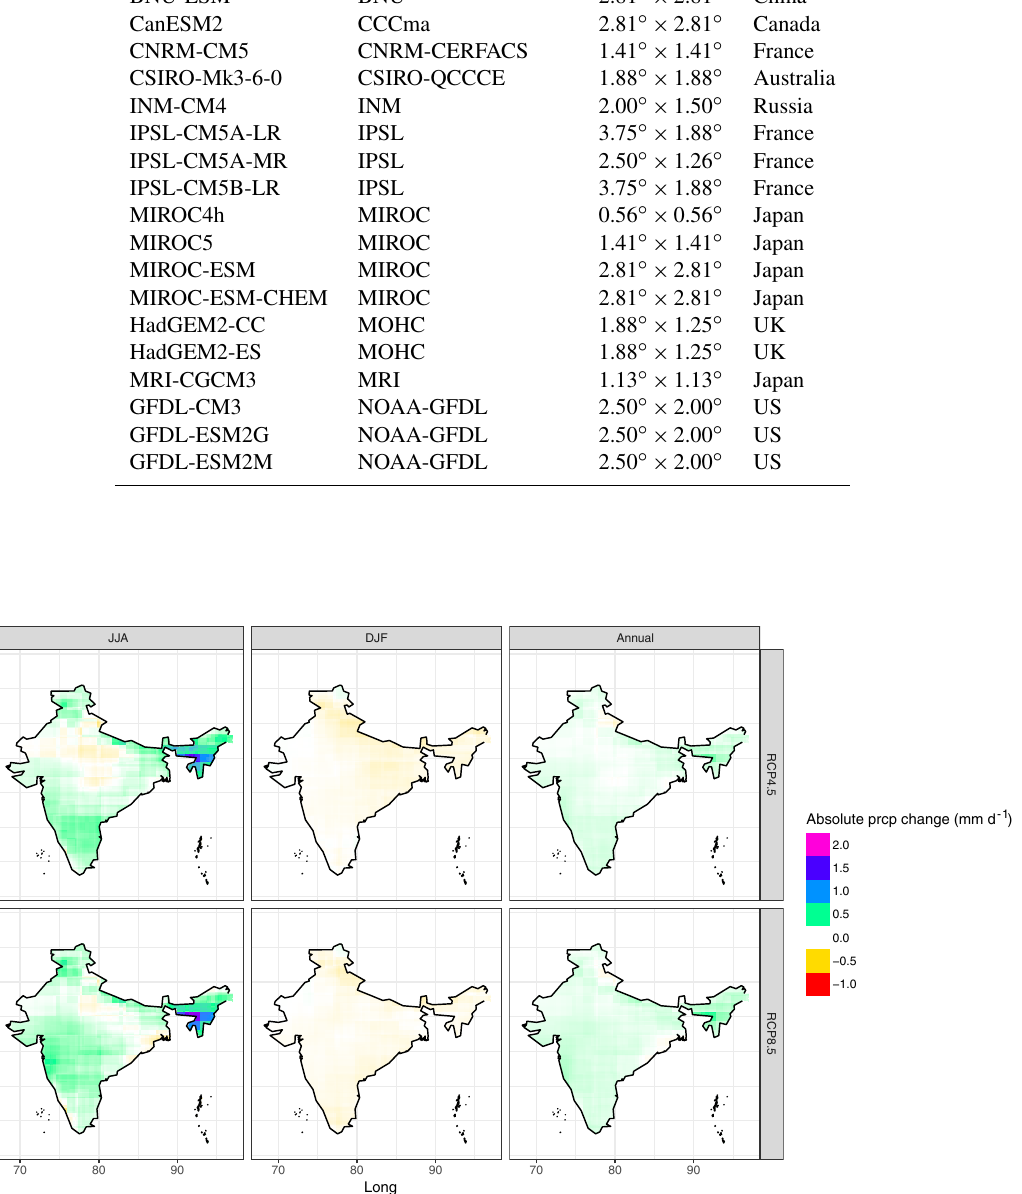
Figure A2. Absolute change (mmd − 1 ) in the multi-model mean precipitation over India between 1975–2005 and 2020–2050. Results are separated under two emission scenarios (RCP4.5 and RCP8.5) averaged over three different periods: the monsoon period (June–August, JJA), the dry winter period (December–February, DJF) and the annual